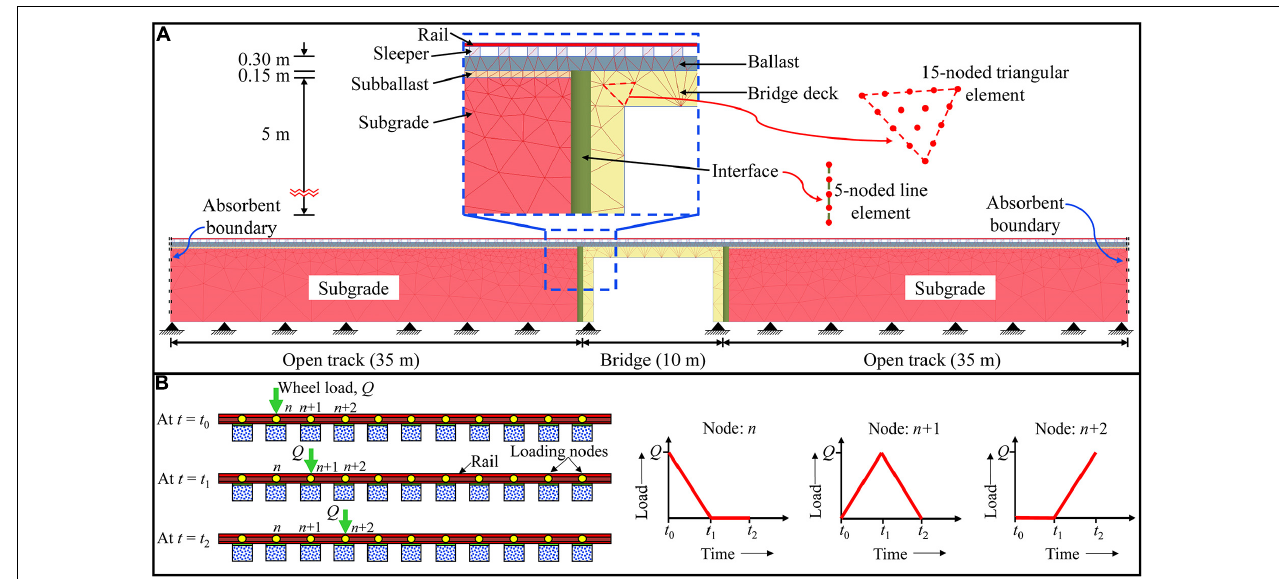
FIGURE 2 | (A) Finite element mesh discretization of the track model; (B) procedure used to calculate the moving train loads.